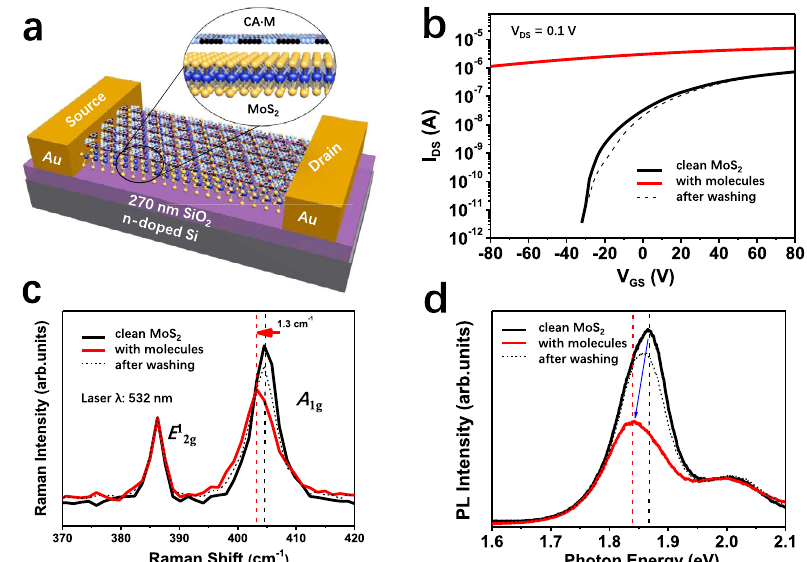
Fig. 3 Electrical and spectroscopic characteristics of monolayer MoS 2 FET with and without the functionalization of melamine and cyanuric acid co-assembled supramolecular network (CA·M). a Schematics of the MoS 2 /CA·M hybrid device. b Transfer characteristics of MoS 2 FET. I DS is the drain current and V GS is the gate potential. c Raman and d Photoluminescence (PL) spectra of the device before (black curve) and after (red curve) CA·M functionalization, acquired under ambient conditions. As prepared MoS 2 samples (black solid), MoS 2 /CA·M (red solid), device after wiping the CA·M network (black dotted). The peak position is labeled with vertical dashed lines, MoS 2 in black and MoS 2 /CA·M in red. The arrows give the direction of the spectra shift: Raman A 1g peak shift in red and PL A exciton peak shift in